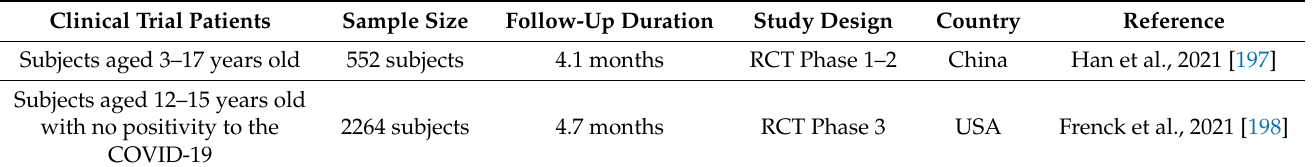
Table 8. Basic features of the encountered randomized controlled trials that were designed for healthy children and adolescents.